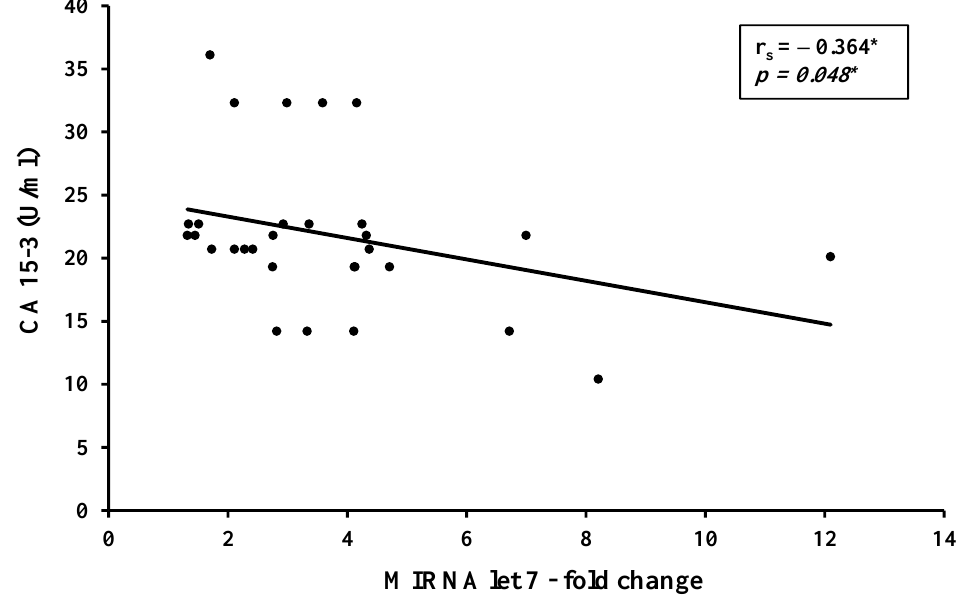
Figure 7. Correlation curve between CA 15-3 and circulating miR-let 7 ( n = 30). * Statistically significant at p ≤ 0.05.